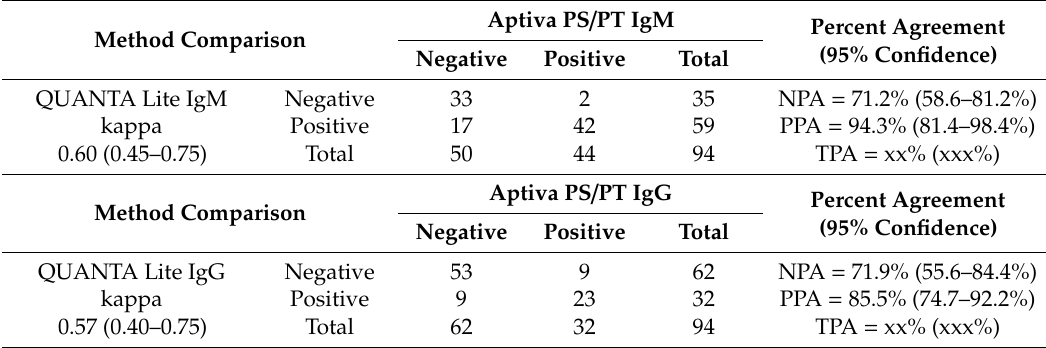
Table 2. 2 × 2 table for aPS / PT testing using ELISA and PMAT